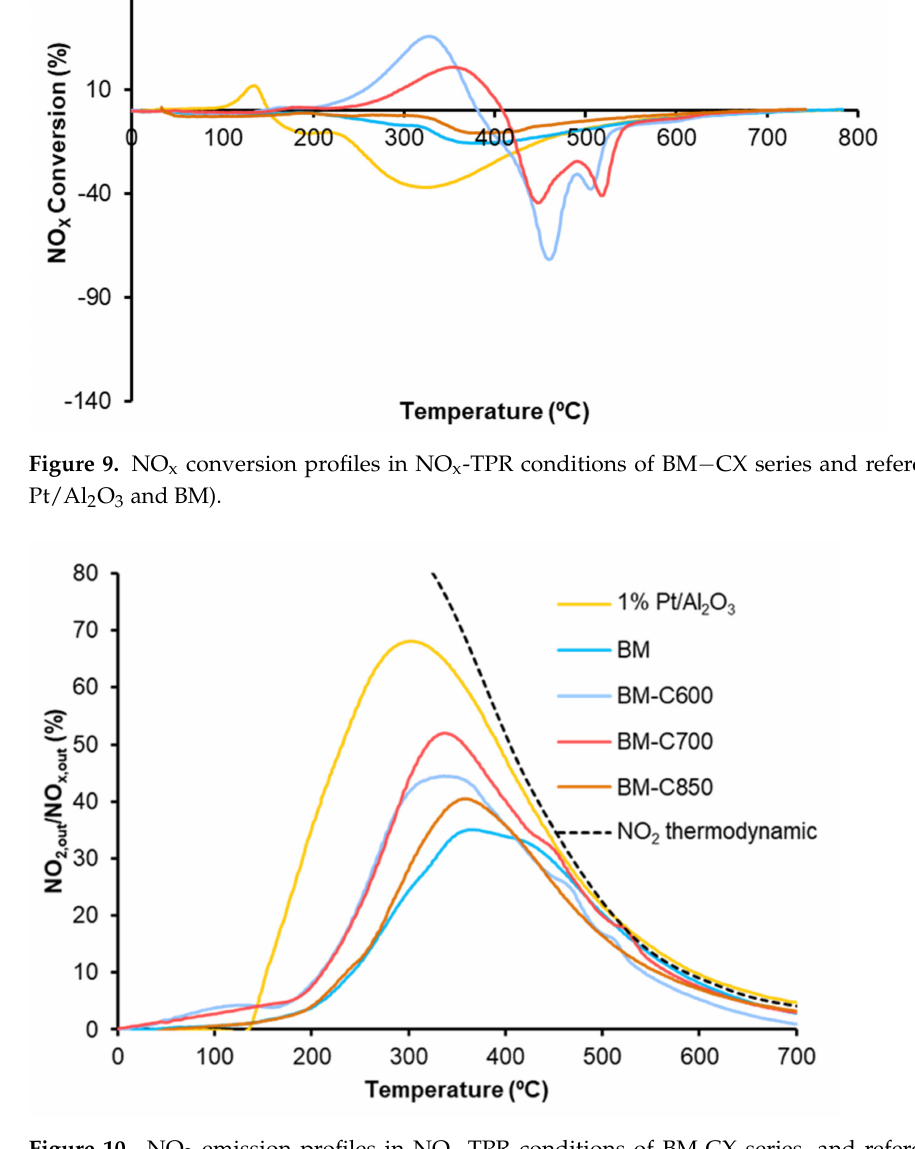
Figure 10. NO 2 emission profiles in NO x -TPR conditions of BM-CX series, and references (1% Pt/Al 2 O 3 and